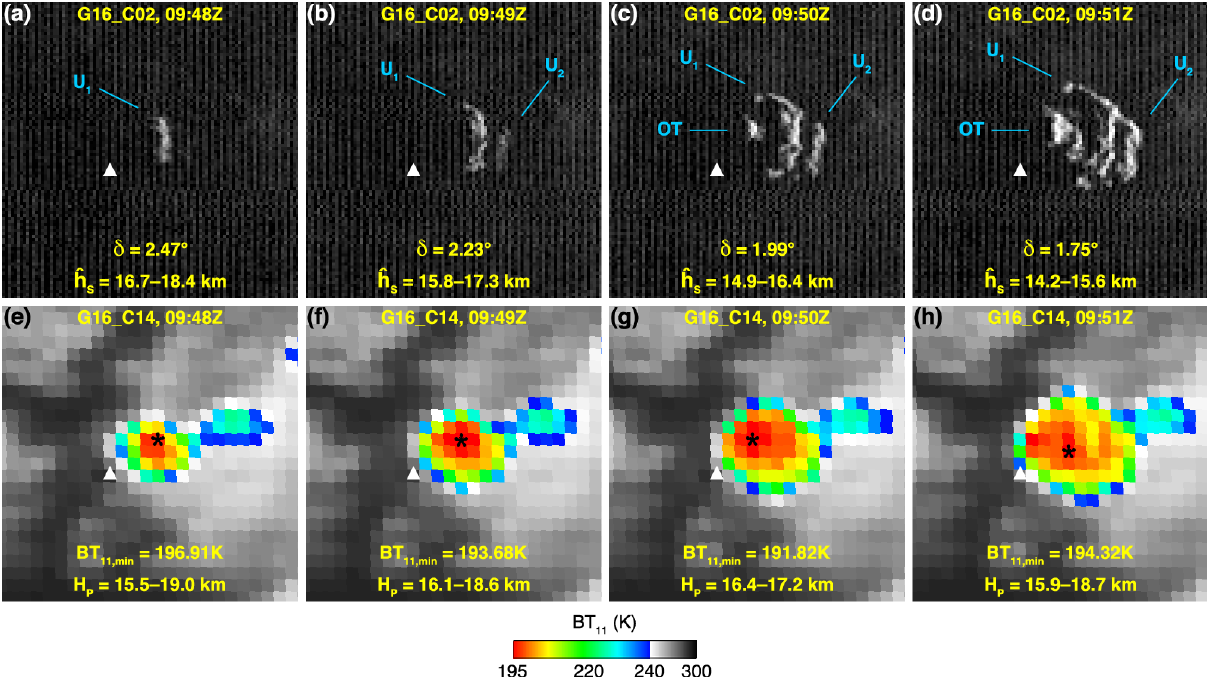
Figure 7. Minute-scale evolution of the eruption plume on 10 April 2021 between (left to right) 09:48–09:51UTC in GOES-16 MESO2 imagery: (a–d) channel 2 and (e–h) channel 14. The labeled plume features are umbrella layer 1 (U 1 ), umbrella layer 2 (U 2 ), and the overshooting top (OT). The unrefracted solar depression angle δ , the estimated effective shadow height ˆ h s , the dark pixel temperature BT 11 , min and its location (black star), and the corresponding min–max radiometric range of the plume height H P are also